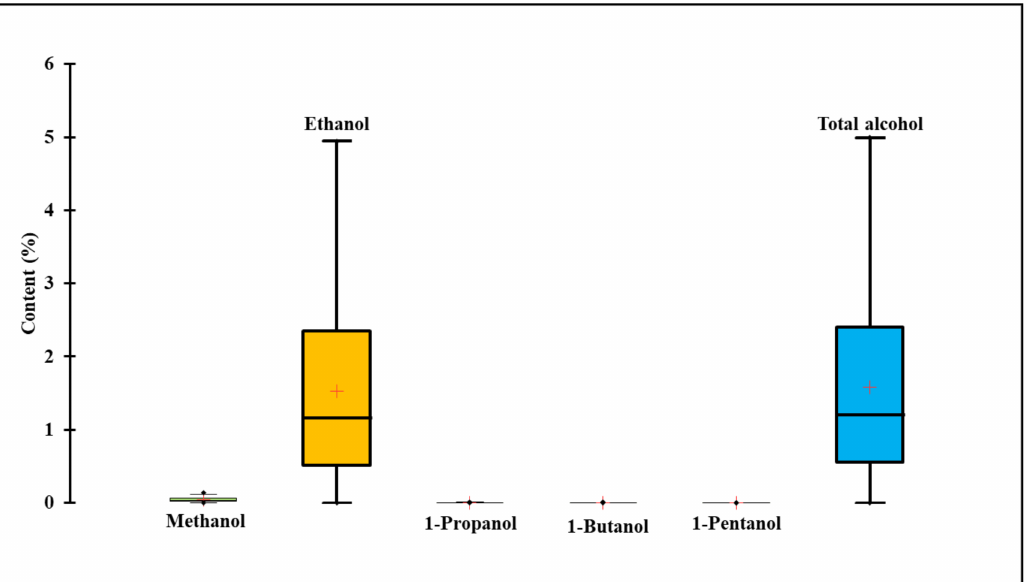
Figure 1. The content of various alcohols in 35 gochujang products from the traditional cottage